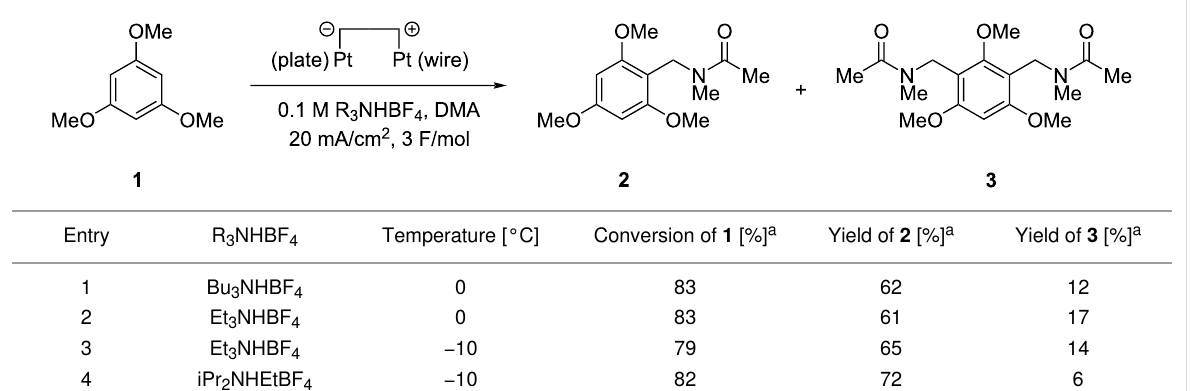
Table 2: Effect of trialkylammonium salt in electrochemical amidomethylation.